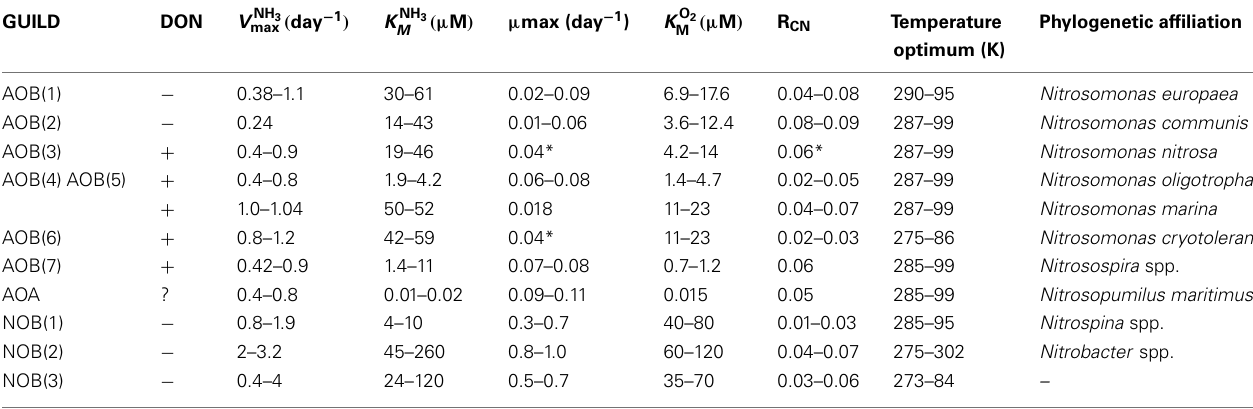
Table 1 |Trait values across the different